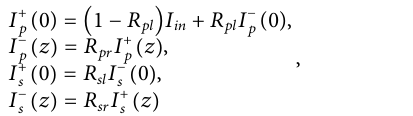
Figure 3. The pump intensity of 1 GWcm − 2 is set in Figures 3A,C. Different optimal transmittances corresponding to different diamond lengths for the maximum output intensity are shown in Figure 3A. As can be seen, the optimal T is larger for the longer length of the diamond, but the output intensity is reduced. The output intensities of 57.1 MWcm − 2 ( L = 1 cm, T = 63%) and 29 MWcm − 2 ( L = 3 cm, T = 87%) are obtained, respectively. In Figure 3B, above the threshold intensity, the